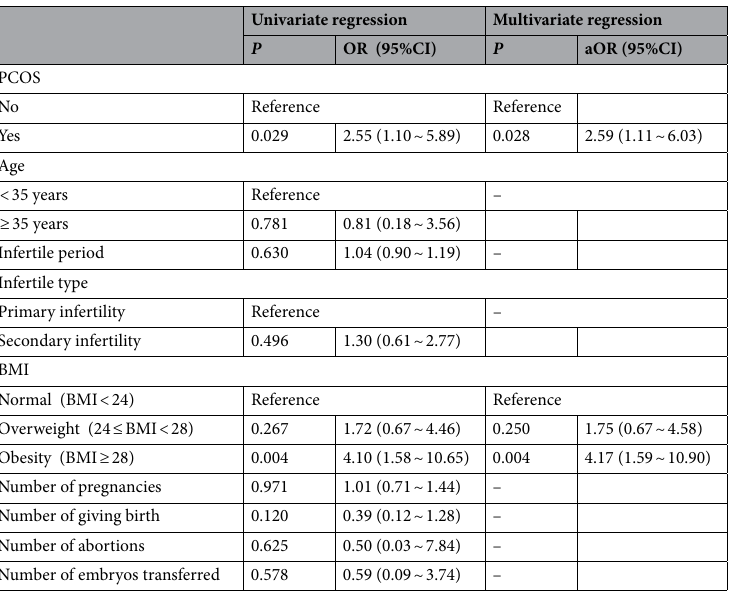
Table 4. Analysis of risk factors for late abortion in twin pregnancy (Based on the data after PSM for clinical pregnancy). PCOS, polycystic ovary syndrome; PSM, propensity score matching; BMI, body mass